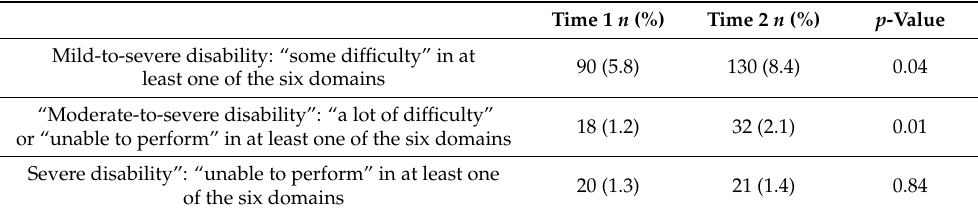
Table 2. Prevalence of disability based on three levels, stratified by